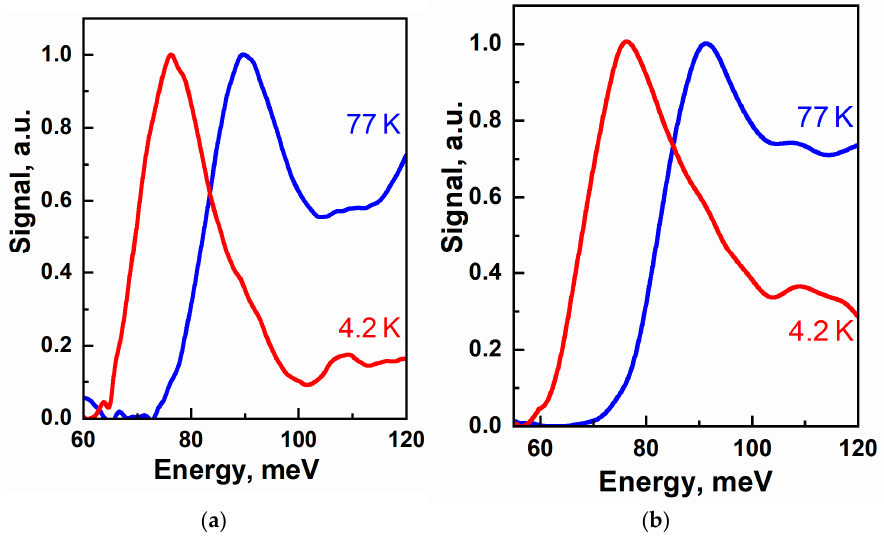
( a ) ( b ) Figure 2. PC spectra of structures at 4.2 and 77 K: ( a ) #A0130; ( b ) #B0225. Table 2. Parameters of structures under study: QW thickness (d) and Cd content in QWs (x) from ex situ characterization, PC cutoff wavelength at 4.2 K and 77 K, SE wavelength at 8 K ( λ SE ) and threshold (I th ), critical temperature of SE quenching (T max ), threshold energy of CCHC Auger recombination (E th ), the PC cutoff width at 4.2 K (W), residual carrier density at 4.2 K (* 77 K, determined via Hall effect measurements) (n dark ). Sample No.